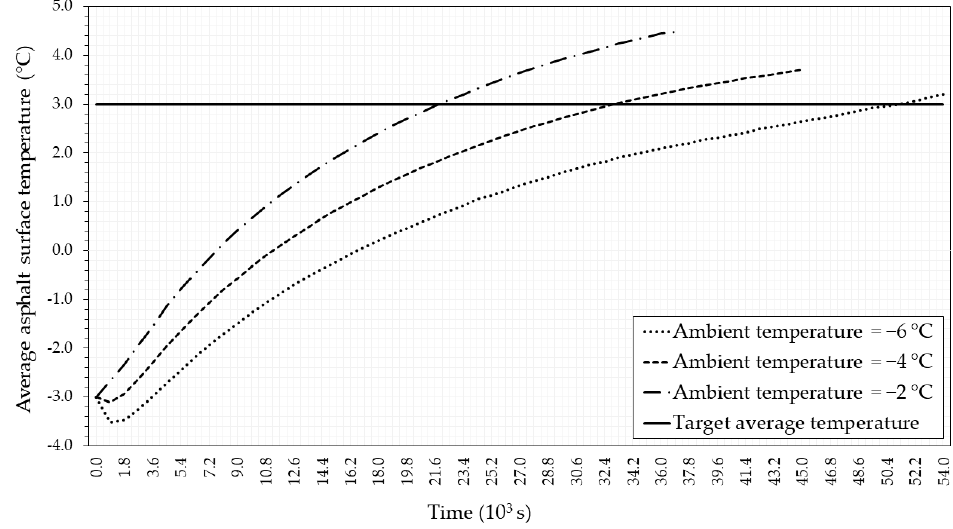
Figure 11. Time interval required to reach and maintain the average temperature of 3 ◦ C at the asphalt surface with initialization at − 3 ◦ C.